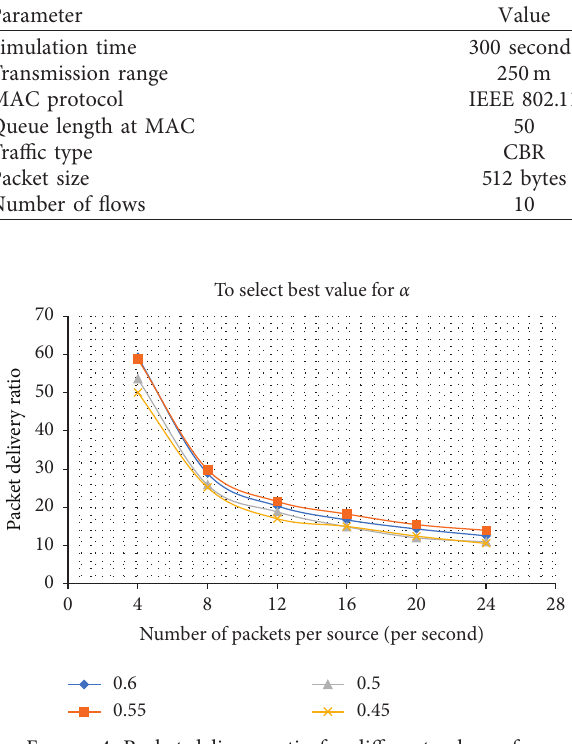
Figure 4: Packet delivery ratio for different values of α Table 2: Parameters of simulation model.